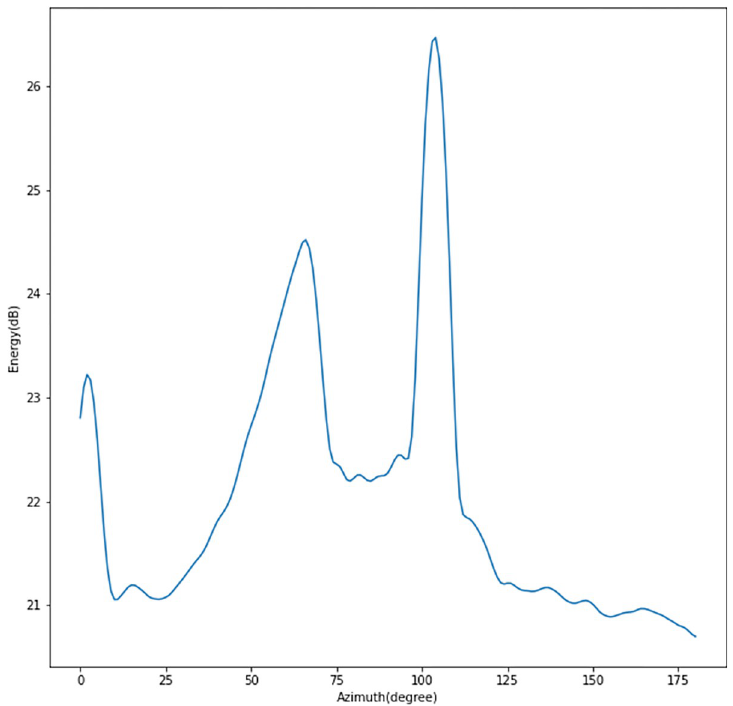
Fig 19. The spatial azimuth energy distribution of the original data of the sonar array at a certain moment obtained by beamforming.